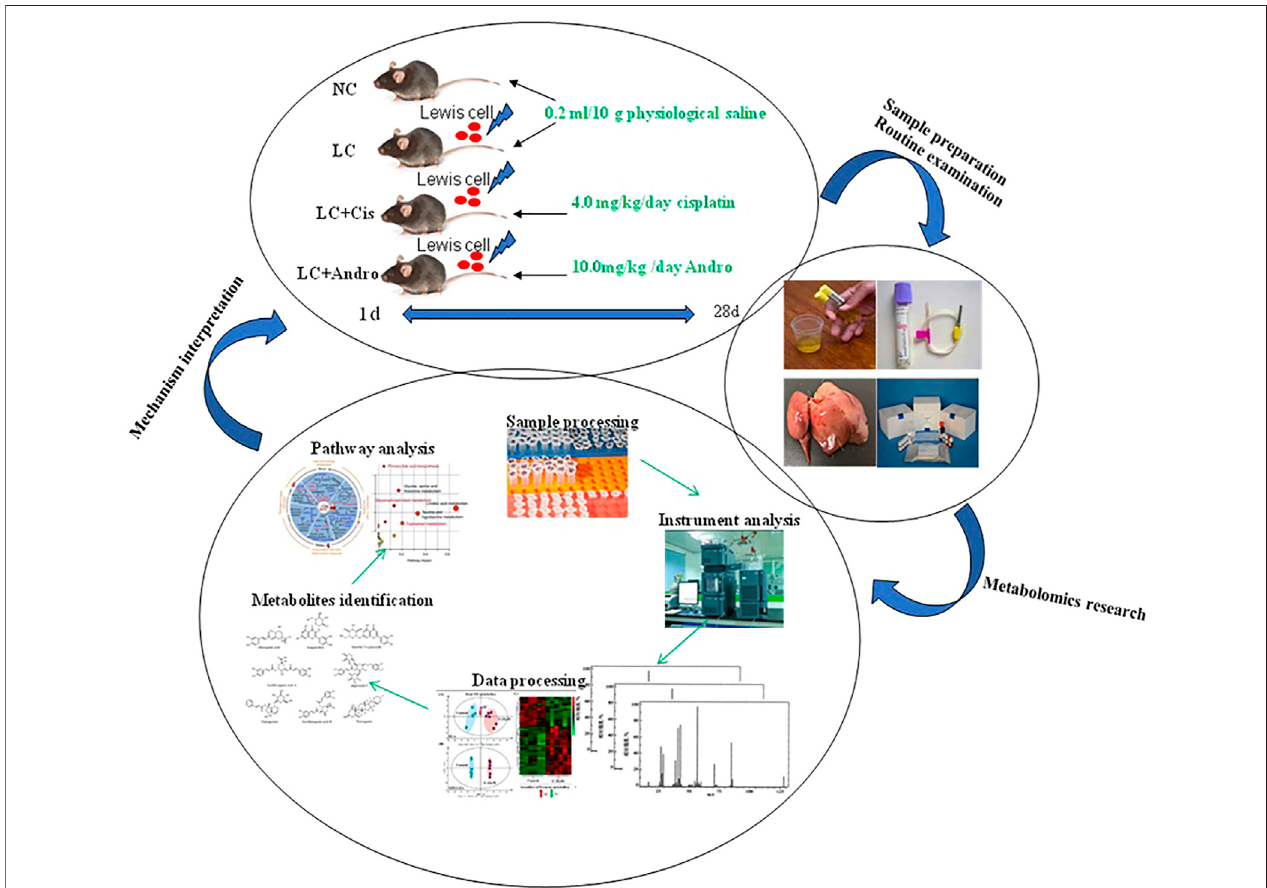
FIGURE 8 | A fl ow chart for the